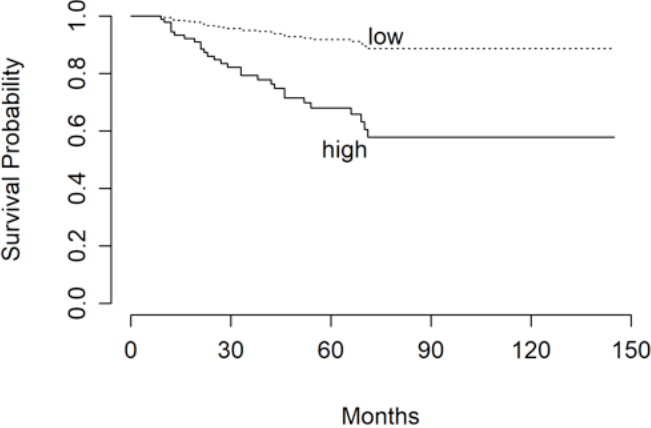
Figure 2. RFS of patients stratified in “low” and “high” risk groups according to Ki67 indices of ≤10% and >10%, respectively.